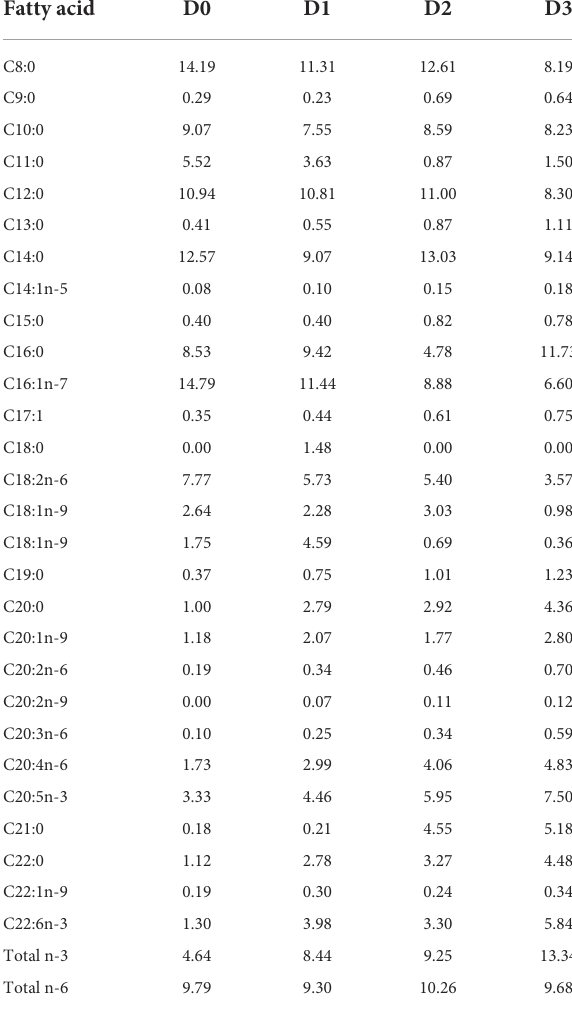
TABLE 1 Feed formulation (%) and proximate composition (% dry matter) of different experimental diets.